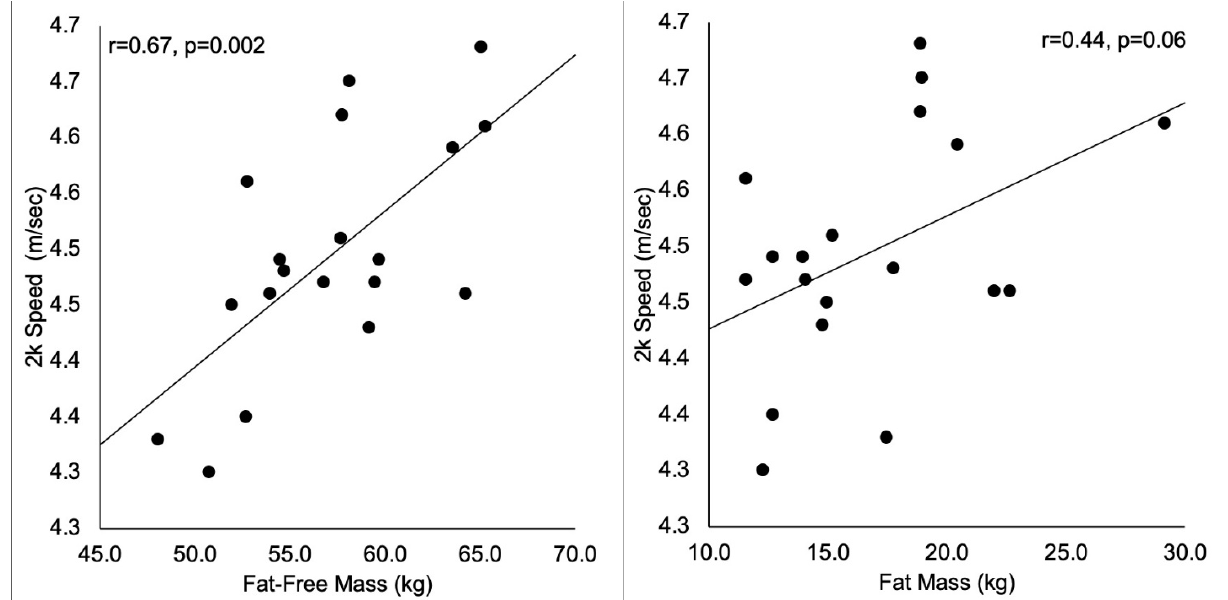
Figure 2. Scatterplots representing the relationships between unadjusted 2 km (2k) speed and the body composition metrics. When adjusted for body weight, 2k performance was not significantly correlated to FFM (Figure 3). However, FM was inversely correlated with adjusted 2k speed (Figure 3), indicating higher FM was associated with lower speeds. This correlation remained statis- tically significant after accounting for height (partial r = −0 .60, p < 0.01).